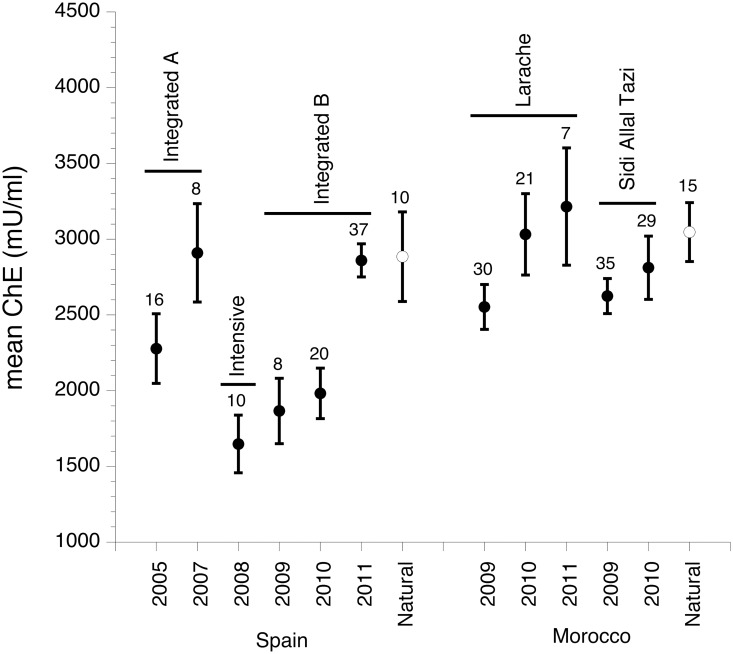
Total cholinesterase activity of Black-winged Stilt (Himantopus himantopus) chicks born over the period 2005–2011.Mean ± s.e. total cholinesterase (ChE) activity (mU/ml plasma) and sample size is given over each bar. Filled circles represent data from birds captured in rice fields, and open symbols data from birds captured in natural marshes.